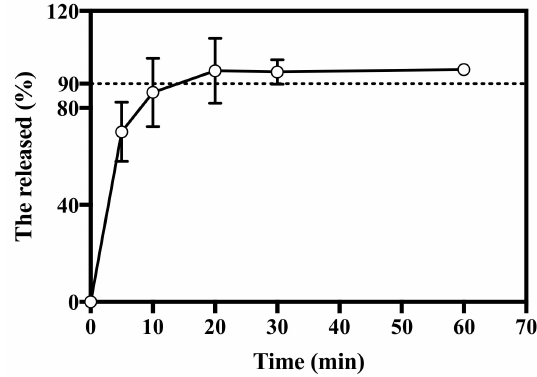
Figure 6. In vitro release profile of HBsAg MN. Dashed line represents 90% of cumulative release ( n = 3).